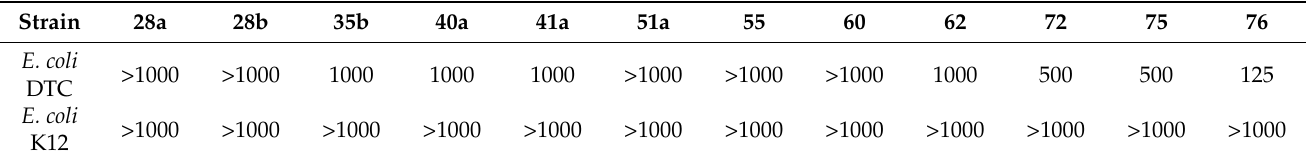
Table 6. Antibacterial effects shown as MIC for E. coli BW25113 DTC and E. coli K-12. MIC values are given in µ